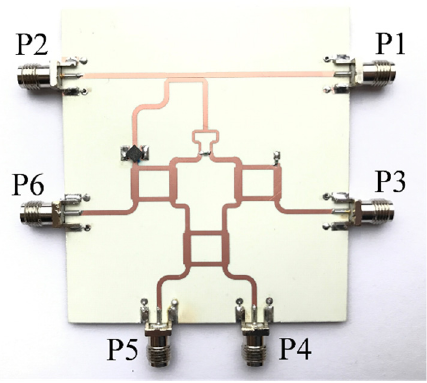
Figure 4. Fabricated six-port junction.